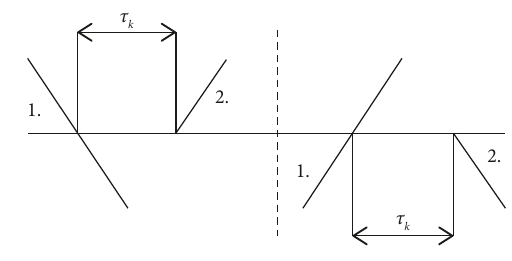
Figure 9: An interval of crossing τ